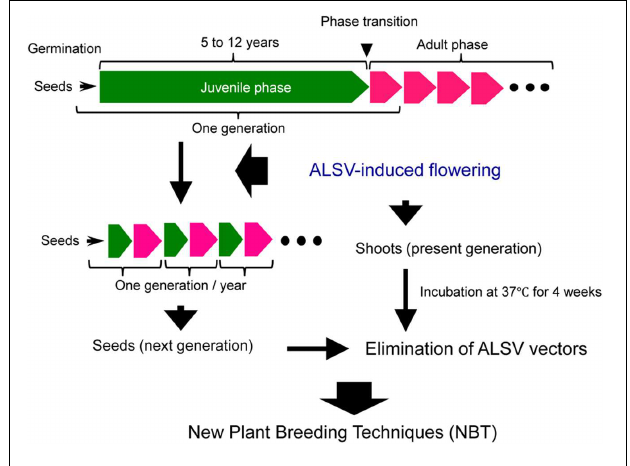
FIGURE 7 | Application of ALSV vector technology, a new plant breeding technique for the accelerated breeding of fruit